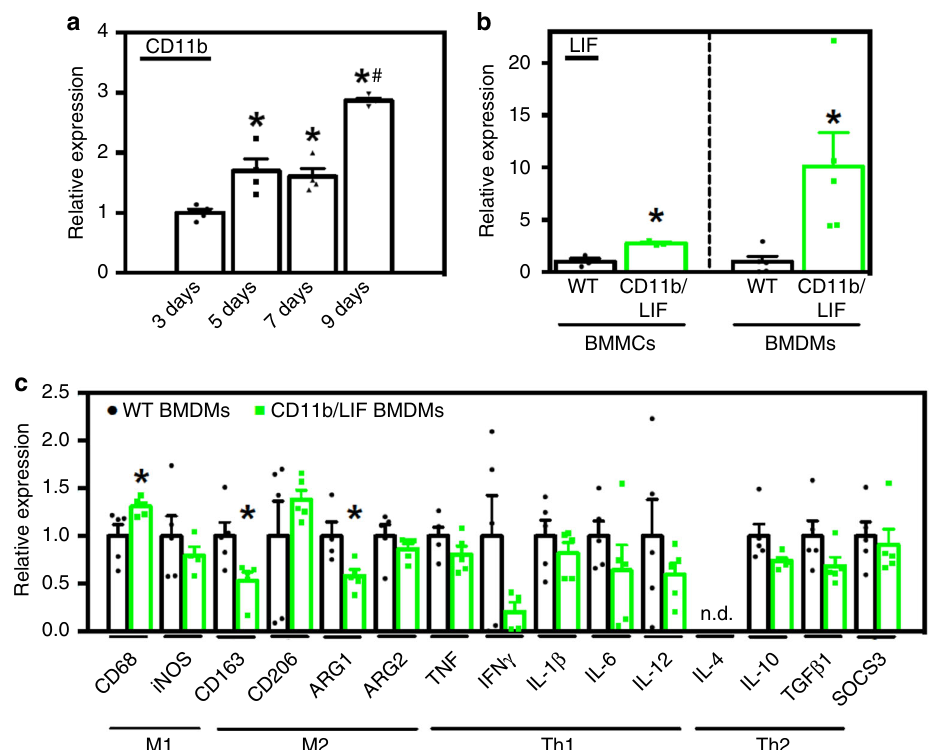
Fig. 1 Differentiation of BMCs into macrophages increases CD11b/LIF transgene expression, causing suppression of M2-biased macrophage markers. a QPCR data showing differences in the level of Cd11b expression in C57BL6 BMCs stimulated with MCSF and differentiated to macrophages for 3 – 9 days. Values are normalized to 3-day cultures, n = 4 for each data set; * indicates signi fi cantly different from 3-day data set and # indicates signi fi cantly different from 5- and 7-day data sets at P < 0.05. P- values based on ANOVA with Tukey ’ s multiple comparison test. For all histograms in the fi gure, the bars indicate mean ± sem. b QPCR data showing increased Lif expression in freshly-isolated BMMCs and BMDMs cultured for 9 days from CD11b/LIF transgenic mice compared to transgene negative littermate controls (WT). Data are presented as mean ± sem. BMCs were isolated from three independent donors, n = 3 per data set. * Indicates signi fi cantly different from WT at P < 0.05. P- values based on two-tailed t- test. F -test BMDMs day 9 ( P = 0.0038). c QPCR analysis shows that CD11b/LIF BMDMs have increased the expression of Cd68 and reduced the expression of Cd163 and Arg1 . Data are presented as mean ± sem, n = 5 for each data set, n = 4 for WT BMDMs Inos , and CD11b/LIF BMDMs Arg1 data sets ( P < 0.05). n.d. indicates that no expression was detected. Data presented for BMDMs ( b , c ) were isolated from a single donor animal of each genotype and cultured as n = 5 technical replicates. Signi fi cant fi ndings were veri fi ed with biological replicates of experiments from independent donors. * Indicates signi fi cantly different from WT BMDMs at P < 0.05. P- values based on two-tailed t- test. F -test Cd206 ( P = 0.0258) and Il10 ( P = 0.0311). Source data are provided as a Source Data fi fi gures obtained by measuring force – strain relationships showed that muscle stiffness (indicated by the slope of the tangent to the loading phase of each cycle) was signi fi cantly less in CD11b/LIF transgenic mdx mice (Fig. 2q, r). In addition, the transgenic mdx muscles showed less energy dissipation during each cycle of loading (proportional to the area inside each hysteresis loop during a cycle of loading/unloading) (Fig. 2q, s), indicating higher mechanical ef fi ciency in the CD11b/LIF transgenic muscles. CD11b/LIF transgene does not impair muscle growth .